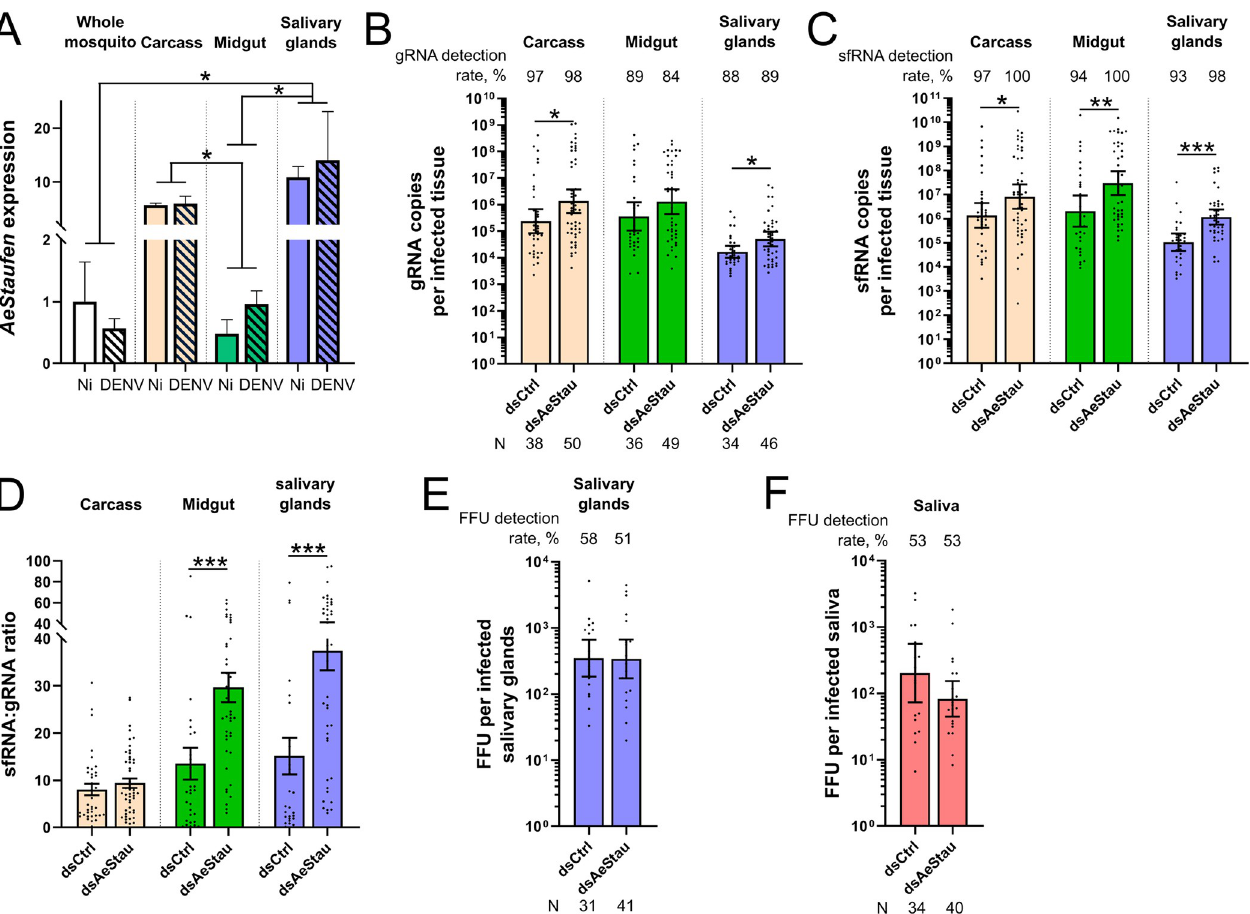
Fig 5. Effect of AeStaufen on gRNA and sfRNA copies, and viral titers in different mosquito tissues. (A) AeStaufen relative expression in whole mosquitoes, carcass (what is left after dissection), midgut, and salivary glands at 10 days post non-infectious (Ni) or infectious blood-feeding (DENV). Bars represent means ± s.e.m. from three replicates of pools of ten tissues. (B-D) Effect of AeStaufen silencing ( dsAeStau ) on gRNA copies (B), sfRNA copies (C) and sfRNA:gRNA ratio (D) in the carcass, midgut and salivary glands at 10 days post-oral infection. (E-F) Effect AeStaufen silencing ( dsAeStau ) on viral titers as determined by focus forming unit (FFU) assay in salivary glands (E) and saliva (F) at 10 days post-oral infection. (B-F) dsLacZ was injected as control. (B, C, E, F) Bars indicate geometric means ± 95% C.I. (D) Bars indicate means ± s.e.m. N, number of mosquitoes analyzed. � , p-value < 0.05; �� , p-value < 0.01; ��� , p-value < 0.001 as determined by unpaired t-test or by LSD-Fisher test (A).